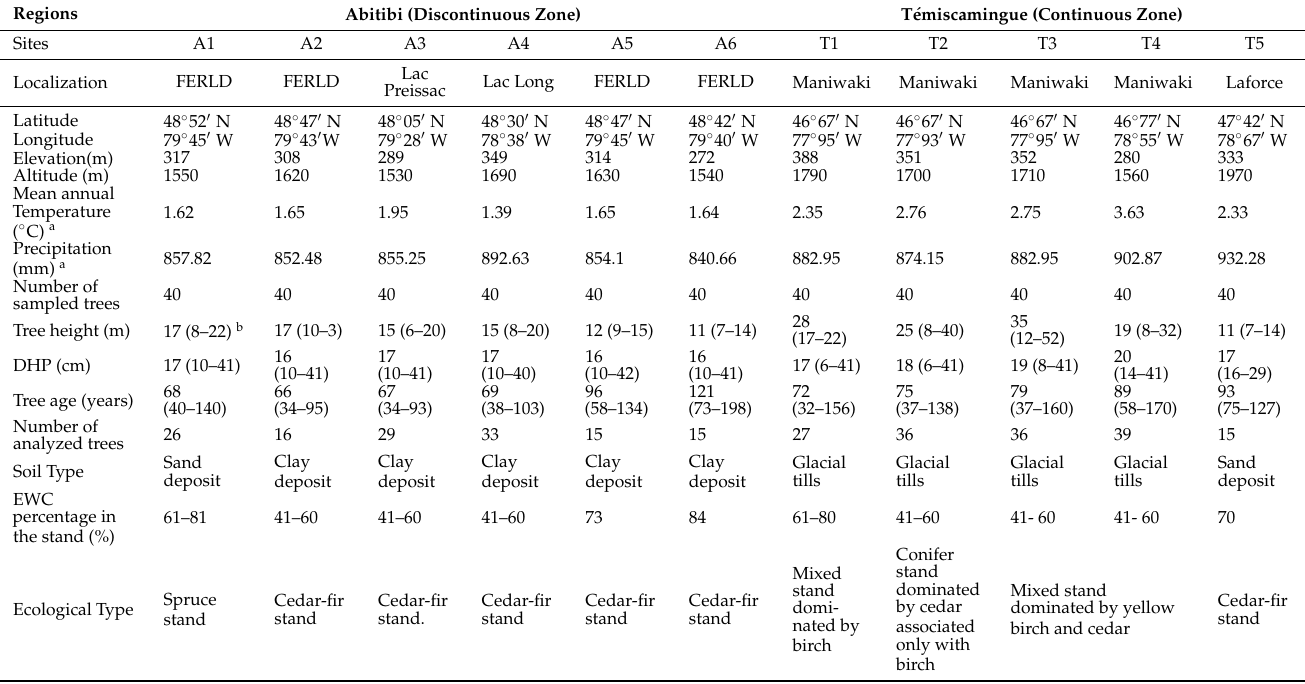
Table 1. Stand and T. occidentalis tree